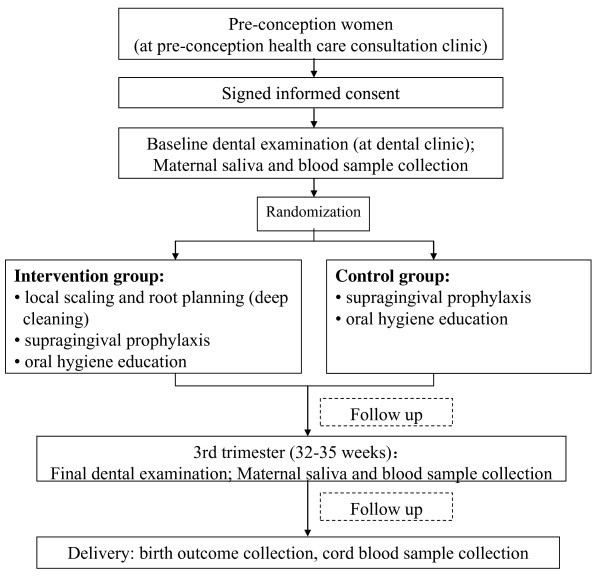
Research flow chart.